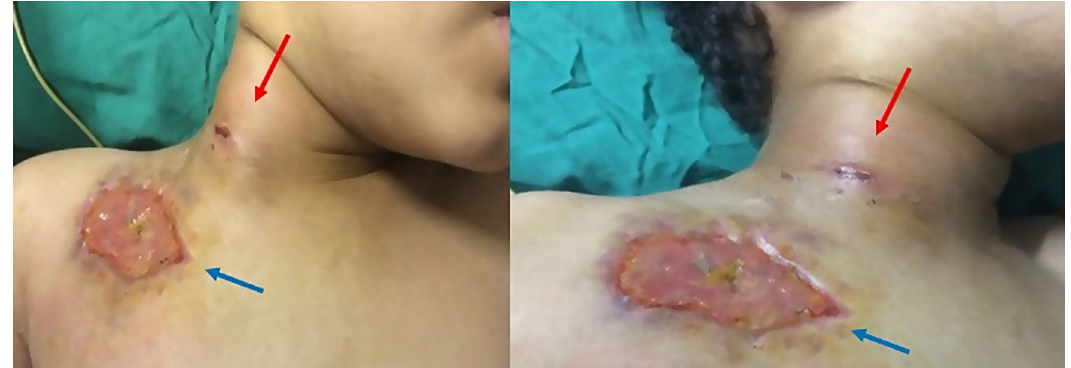
Figure 1. Right latero-cervical mass (3 cm of large axis), with inflammatory signs all around (red arrow) with cutaneous ulceration 5 cm in diameter located under the right clavicular (blue arrow) (former location of the implantable